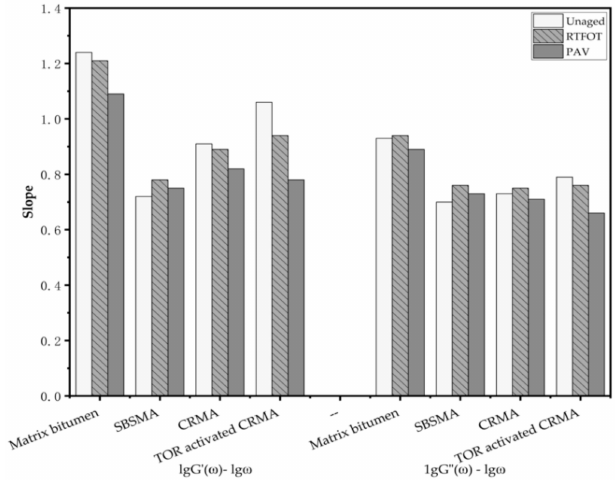
Figure 7. The slopes of lg G (cid:48) ( ω )-lg ω , 1g G”( ω )-lg ω of di ff erent asphalt binders at 60 ◦